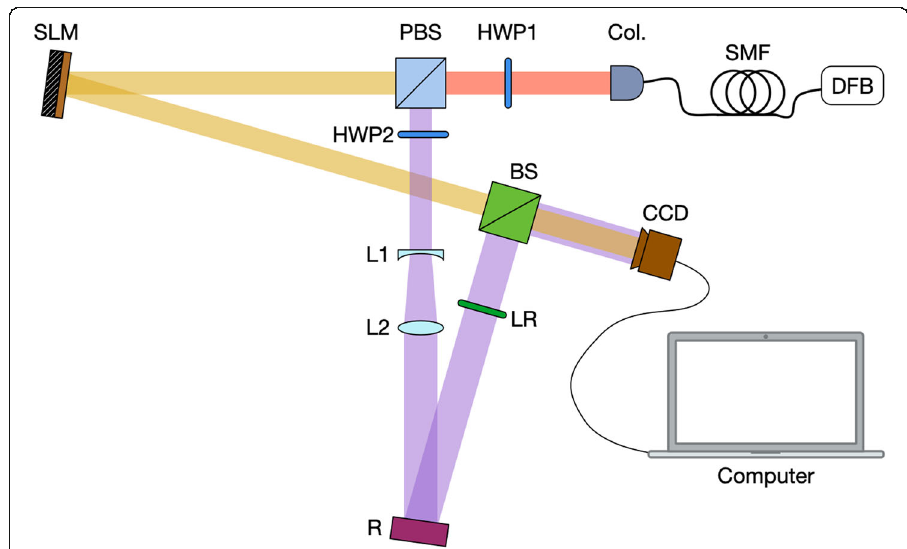
Fig. 2 The schematic experimental setup to demonstrate the universal OAM spectrum analyzer. DFB, Distributed feedback laser; SMF, single mode fiber; Col., collimator; HWP1 & HWP2, half wave plates; PBS, polarized beam splitter; SLM, liquid-crystal spatial light modulator; L1 & L2, a beam expender consists of concave and convex lenses with the focal length f 1 = − 50 mm and f 2 = 200 mm separately; R, reflector; LR, liquid-crystal retarder; BS, non-polarized beam splitter; CCD, infrared CCD